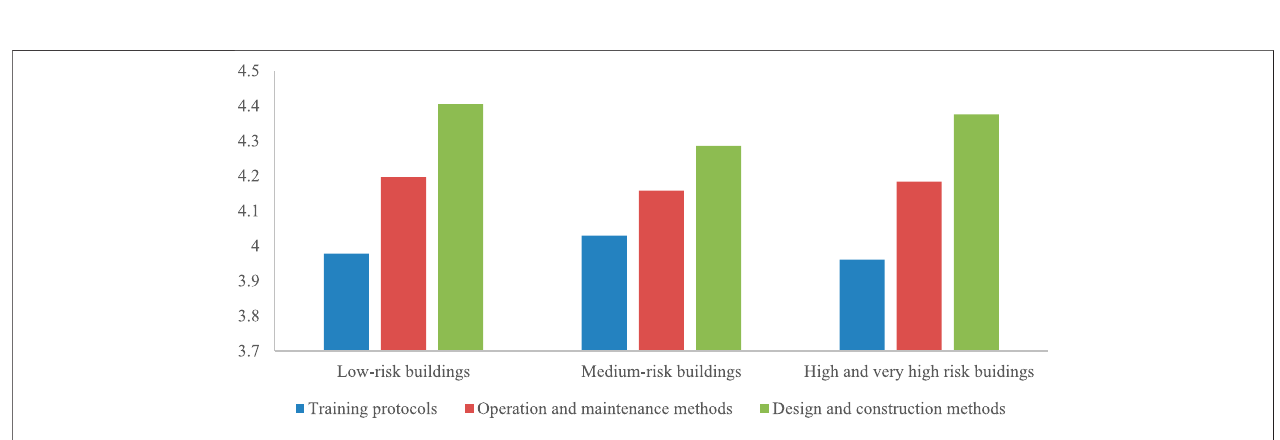
FIGURE 3 | Comparing the effect of methods based on all types of